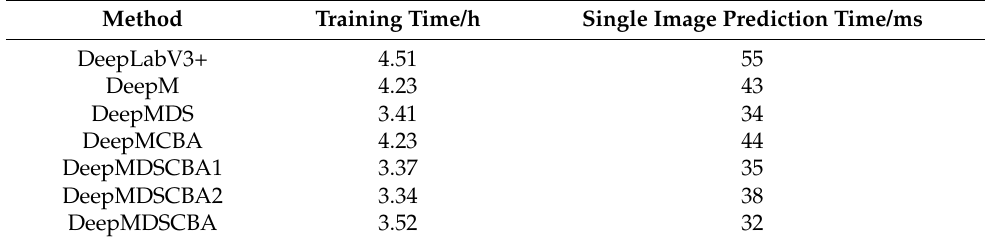
Table 16. Segmentation efficiency of training in ablation